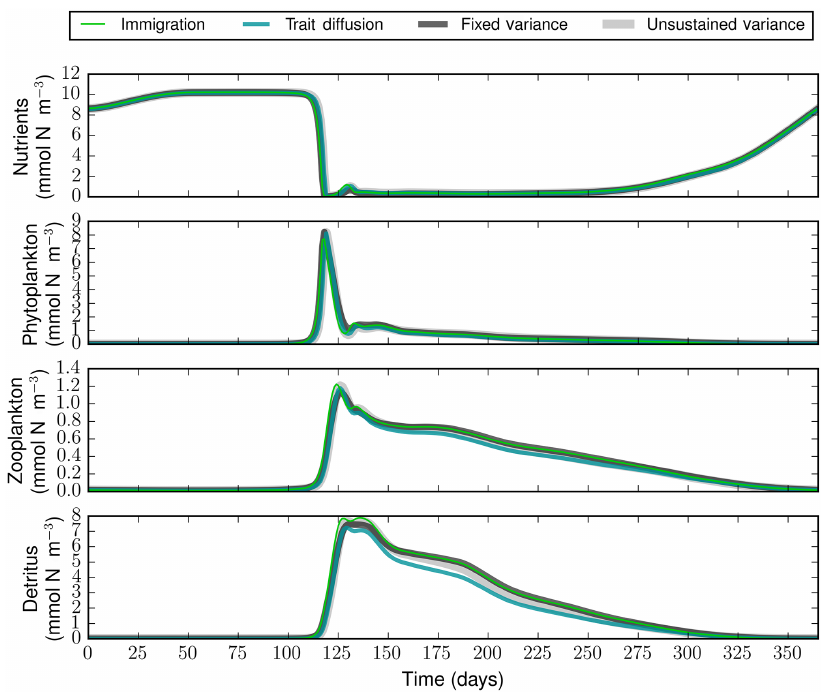
Figure 5. Nutrient, phytoplankton, zooplankton, and detritus dynamics over a seasonal cycle for the four variants of the aggregate model (see Sect. 2.1.3), named unsustained and fixed variance, trait diffusion, and